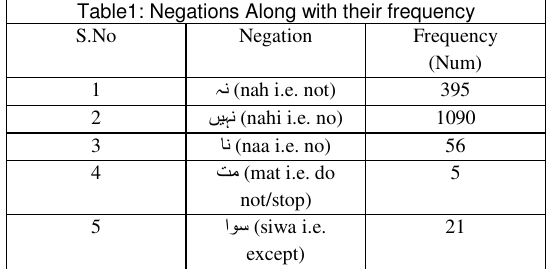
Table1: Negations Along with their frequency